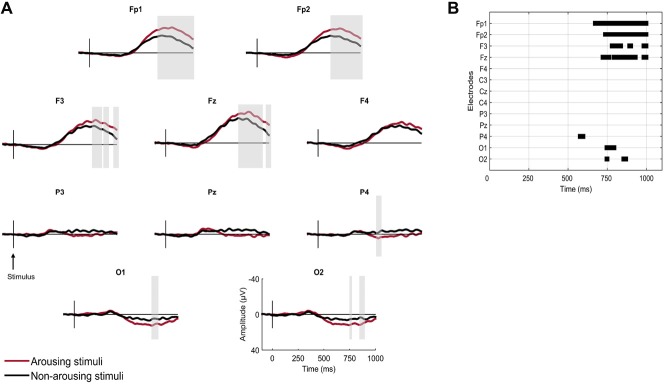
Brain responses to first names according to the presence or absence of an arousing reaction following the stimulus in N2 sleep. (A) Grand averaged responses. Gray vertical bars highlight significant differences (sample-by-sample Wilcoxon test, p < 0.05 for more than 15 ms). (B) Statistical significance of sample-by-sample Wilcoxon test (p < 0.05 for more than 15 ms) performed at 10 electrodes in the post-stimulus period.